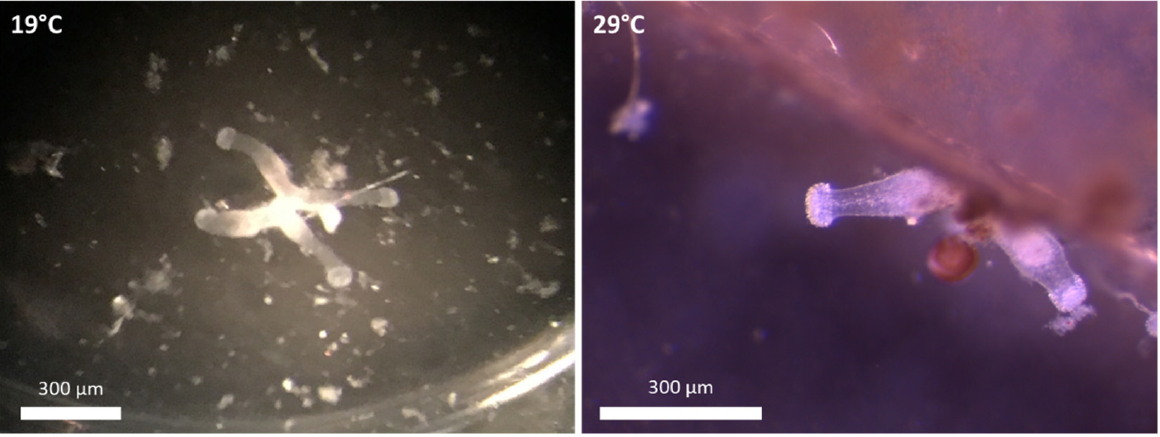
Figure 1. ( A ) Development of the total number of Craspedacusta sowerbii polyps and ( B ) mean (± standard deviation) number of polyps per colony at 19 and 29 °C, respectively.